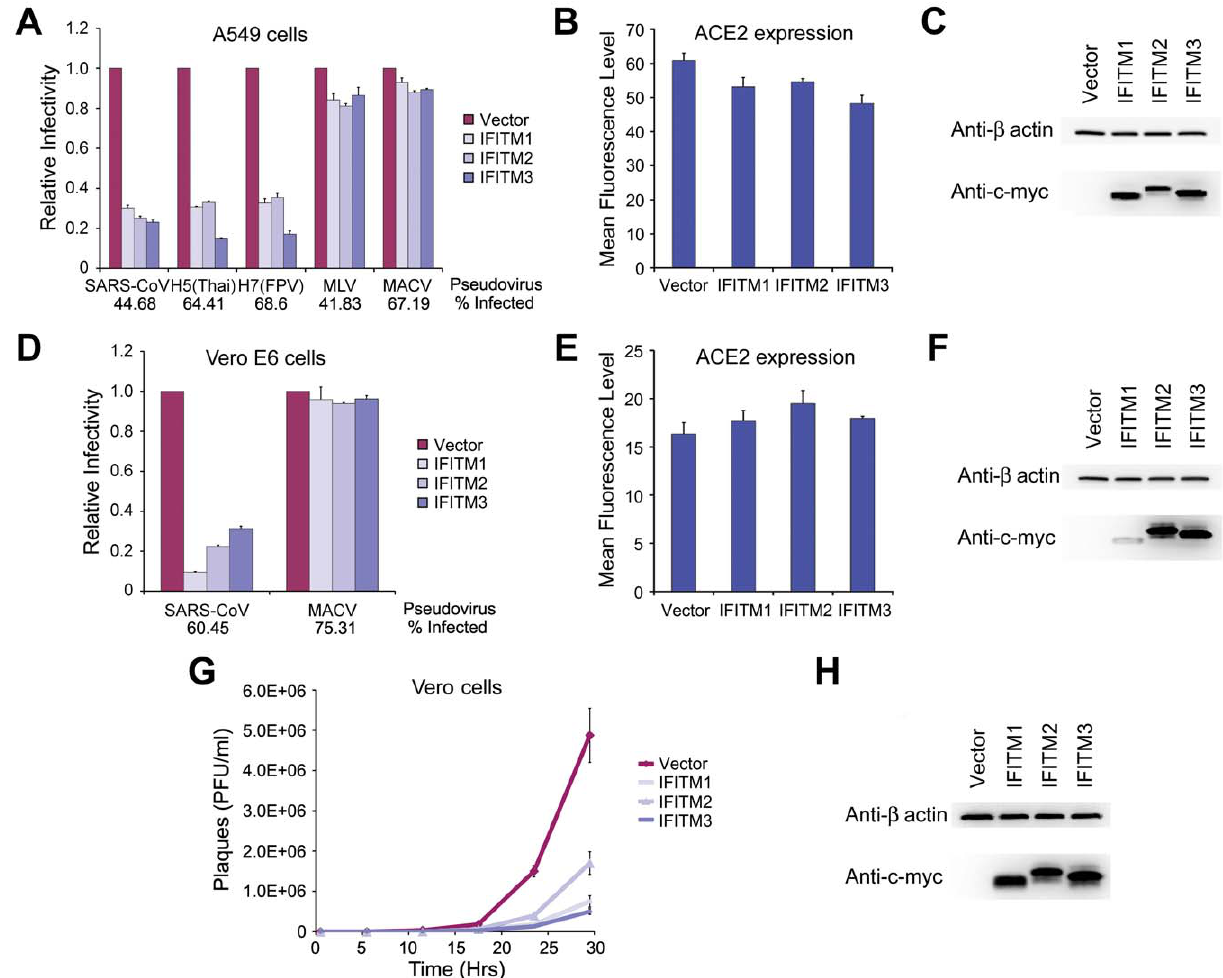
Figure 3. SARS-CoV S infection is restricted by IFITM1, 2, and 3. ( A ) A549 or ( D ) Vero E6 cells transduced to express ACE2 were subsequently transduced to express the indicated c-myc-tagged IFITM proteins or with vector alone. Two days later, cells were infected with indicated pseudoviruses. Pseudovirus infection was determined by flow cytometry, and normalized to that of cells transduced with vector alone. Differences in pseudovirus entry between vector alone and IFITM expressing cells are significant ( P , 0.05) for all SARS-CoV and IAV pseudoviruses. In parallel, cell- surface expression of ACE2 was assayed using aliquots of the same ( B ) A549 or ( E ) Vero E6 cells analyzed in (A) and (D), respectively. Cells were labeled with Alexa-488 conjugated S protein RBD of SARS-CoV and analyzed by flow cytometry. ACE2 expression is shown as mean fluorescence intensity. Expression of c-myc-tagged IFITM proteins was assayed by western blot using aliquots of the same ( C ) A549 or ( F ) Vero E6 cells analyzed in (A) and (D), respectively. Each panel represents at least three experiments with similar results. ( G ) Vero cells transduced to express indicated c-myc- tagged IFITM proteins or with vector alone were incubated in duplicate with infectious SARS-CoV at a MOI of 0.1 for 1 hour. Supernatants were harvested 1, 6, 12, 18, 24, or 30 hours later and viral titers were measured by plaque assay. ( H ) Expression of c-myc-tagged IFITM proteins was assayed by western blot using aliquots of cells analyzed in (G).